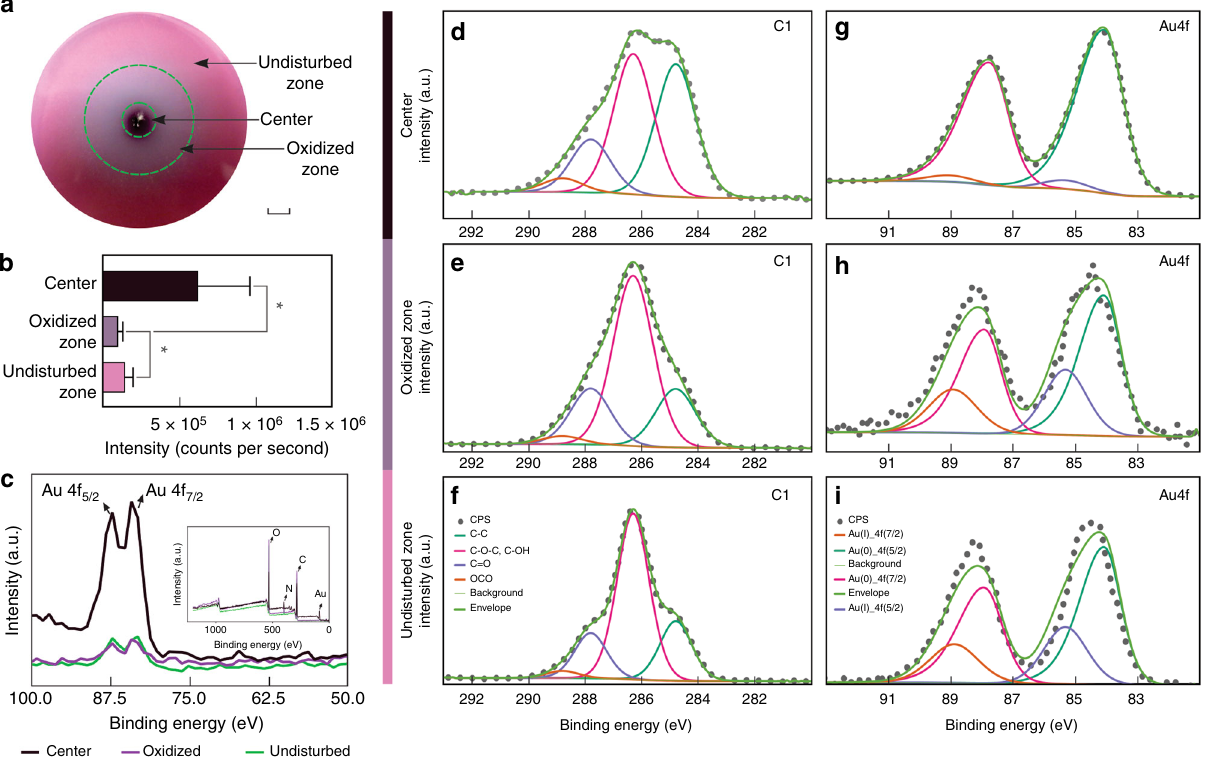
Fig. 3 Gold-oxidizing capacity of TA_pink1. a TA_pink1 was inoculated at the center of PYG agar plates supplemented with 400 μ M colloidal gold. After 14 days of incubation at 10 °C in the dark, a gold-dissolving halo appeared around the central colony, dividing the agar into three zones: center, oxidized zone, and undisturbed zone. Scale bar, 1 cm. b Quanti fi cation of gold intensity in different zones of the PYG agar by LA-ICP-MS. The horizontal axis represents the gold signal in counts s − 1 . Error bars represent standard deviation, * P < 0.001. c Expanded gold pro fi le from XPS analysis. The inset shows pro fi les of major elements, including signals from O 1s (531.0 eV), C 1s (285.1 eV), N 1s (399.5 eV), and Au 4f (84.0 eV). High-resolution scans of C 1s ( d – f ) and Au 4f spectra ( g – i ) from different zones. Gray dots represent the intensity of the spectra in counts per second